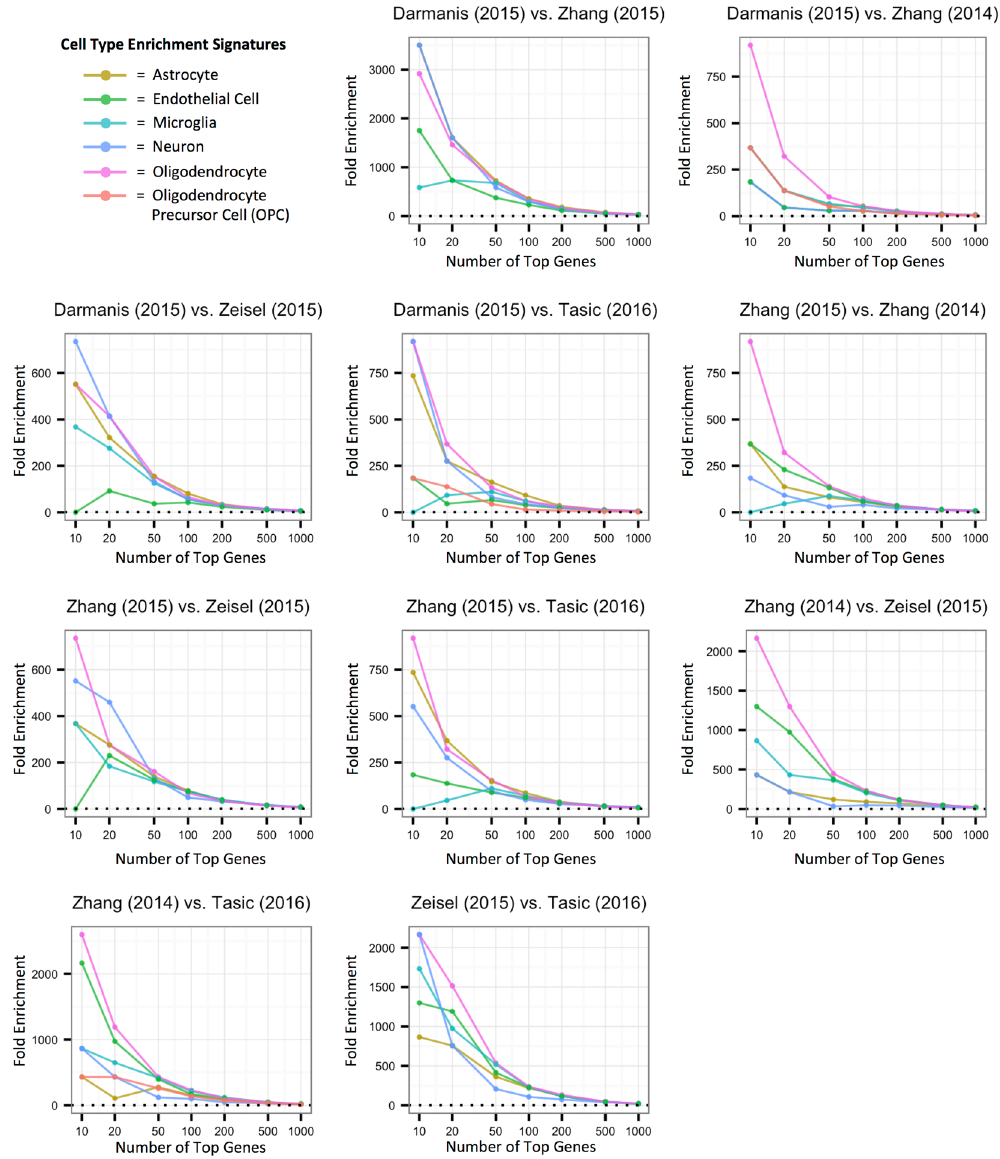
Figure 3. Pairwise data set comparison of cell type enrichment rankings for each cell type. Plots of the fold- enrichment of the intersections of genes ranked in the top n genes (where n = 10, 20, 50, 100, 200, 500, 1000) between pairs of data sets for the cell type enrichment measure. The data sets were merged to only include gene symbols common to both prior to calculating the fold enrichment score. A fold enrichment of 0 indicates that no genes were found in the intersection of those two sets of top